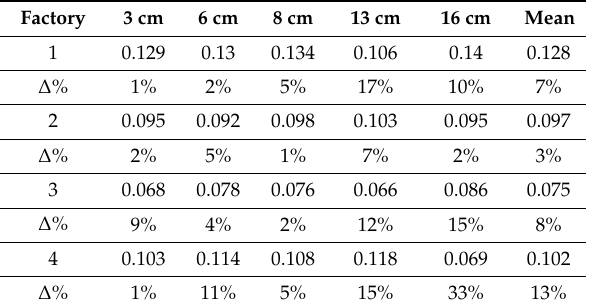
Table 6. Dry thermal conductivity—intensive samples.